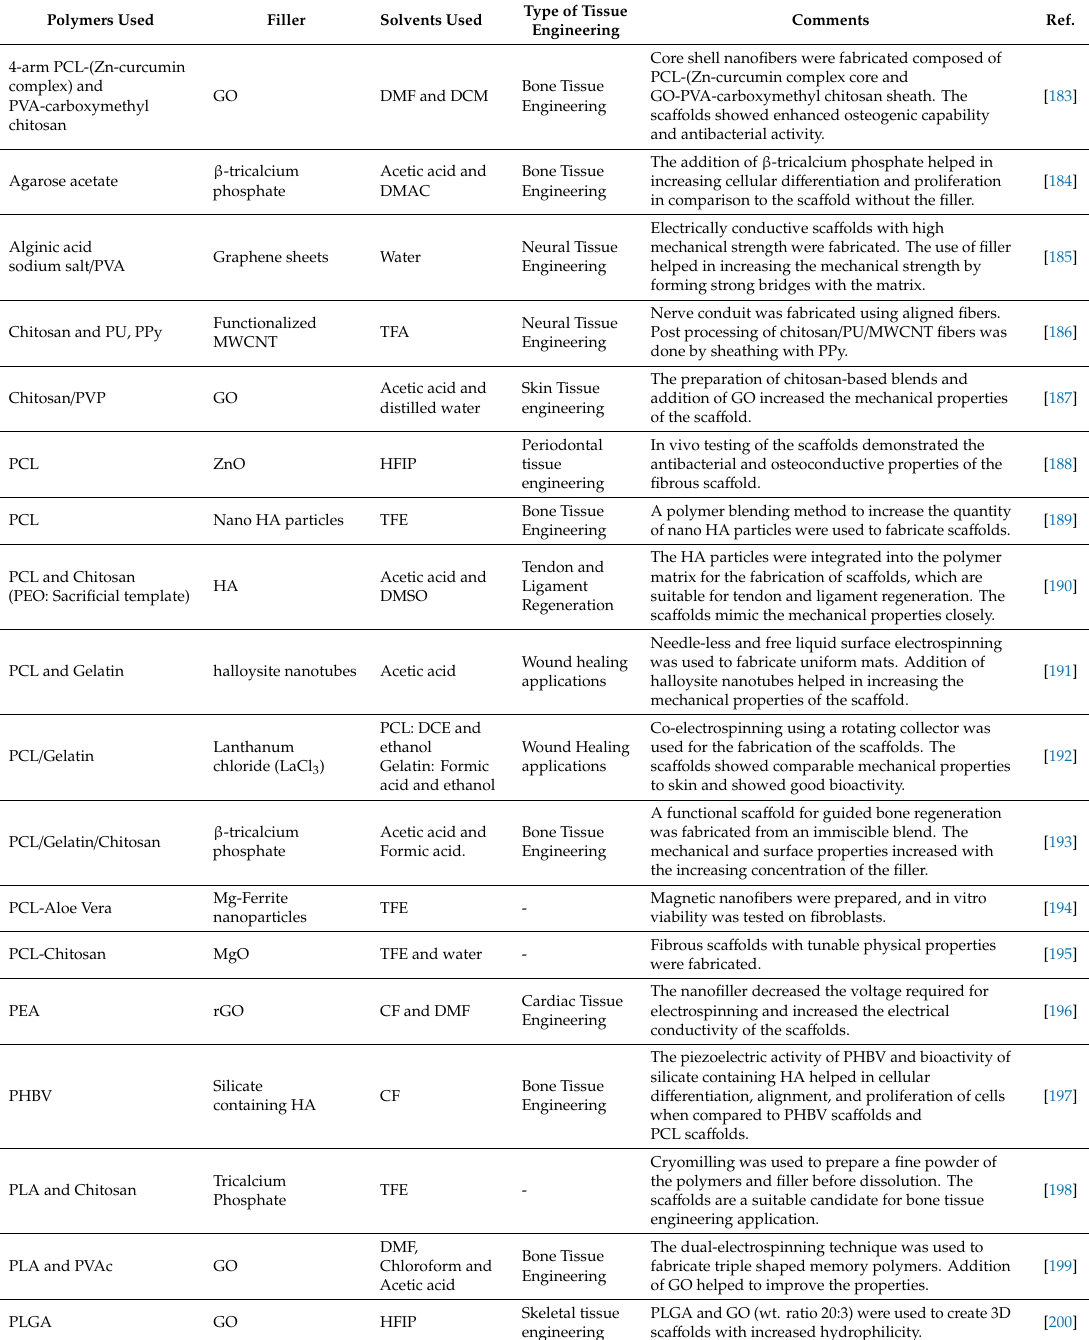
Table 5. Electrospun sca ff olds based on the use of nanofiller